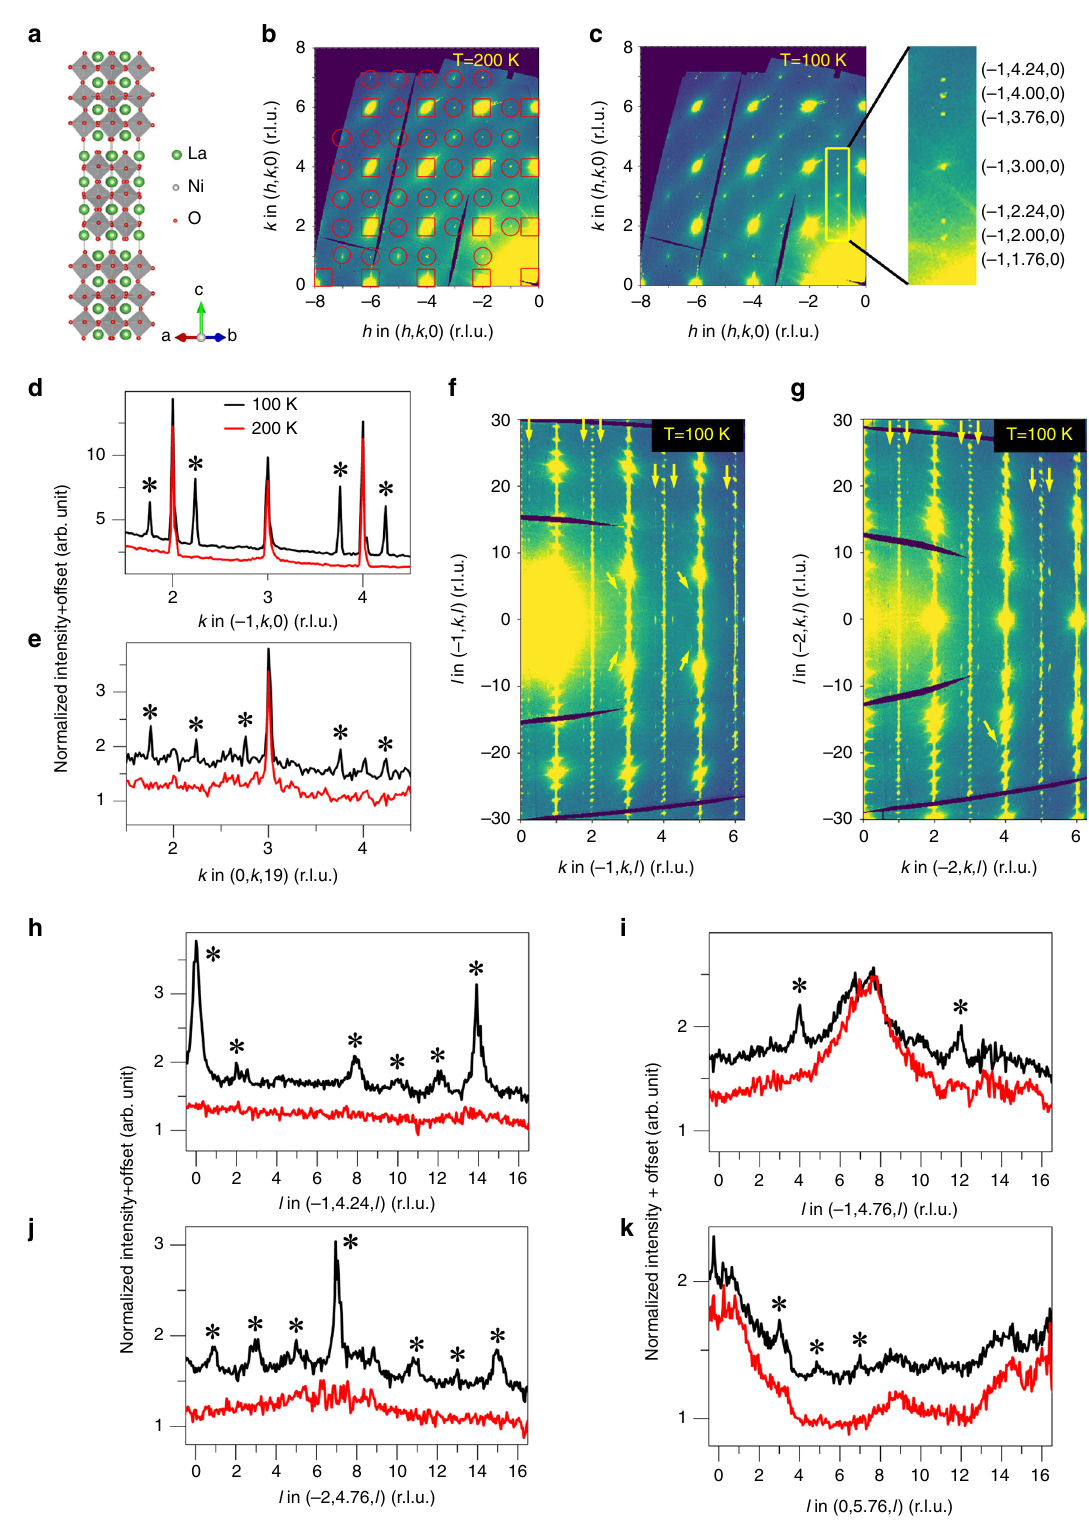
Fig. 2 Charge density wave order in La 4 Ni 3 O 10 . a Crystal structure of La 4 Ni 3 O 10 . The unit cell contains two trilayer perovskite-like blocks that are related through the B -centering operation of the Bmab space group. b hk 0 plane at 200 K as measured at Sector 15-ID-D. The data are integrated over 0.05 r.l.u. in l . Hollow squares, fundamental Bragg peaks from high symmetry Bmab ; hollow circles, Bragg peaks resulting from monoclinic distortion to P 2 plane at 100 K. d , e Line cuts through data along k direction at 100 and 200 K. The cuts have been integrated over 0.04 r.l.u. in h and 0.05 r.l.u. in l . f , (cid:1) 1 kl plane at 100 K. The data are integrated over 0.02 r.l.u. in h ( h = − 1). g (cid:1) 2 kl plane at 100 K. h – k Line cuts through data along l direction at 100 and 200 K. Note red for 200 K and black for 100 K. The cuts have been integrated over 0.02 r.l.u. in h and 0.04 r.l.u. in k . In d , e , h – k , the data are shifted for clarity. Asterisks (*) mark the superlattice re fl ections. Yellow arrows in f , g point to superlattice re fl